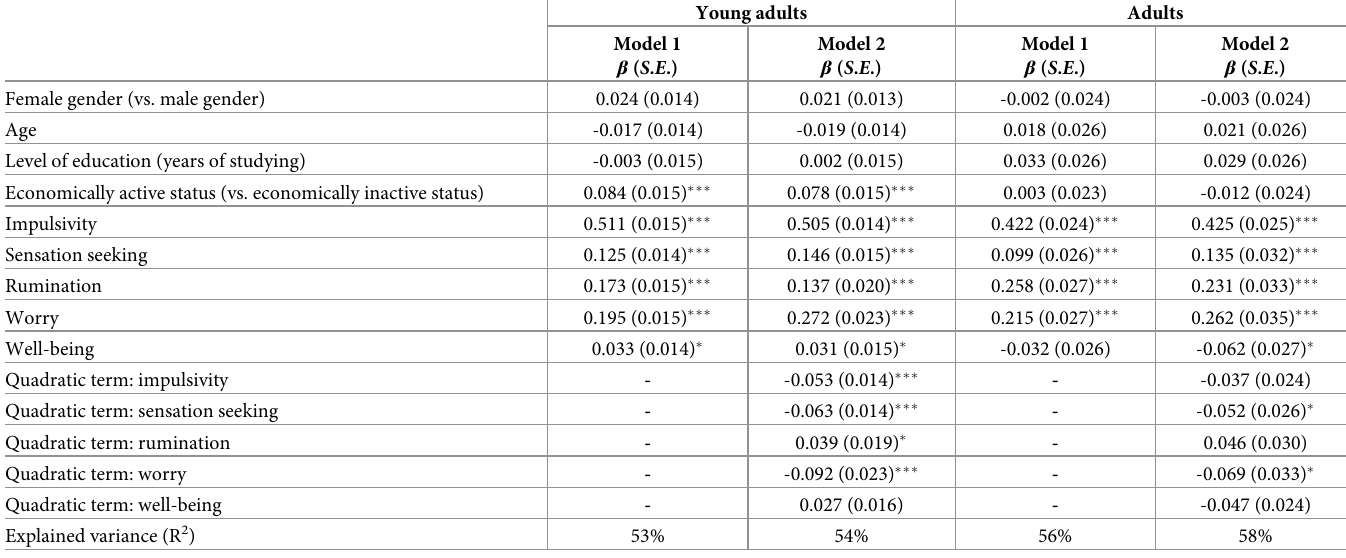
Table 3. Predictive effects on the latent factor of mentalization difficulties assessed by the